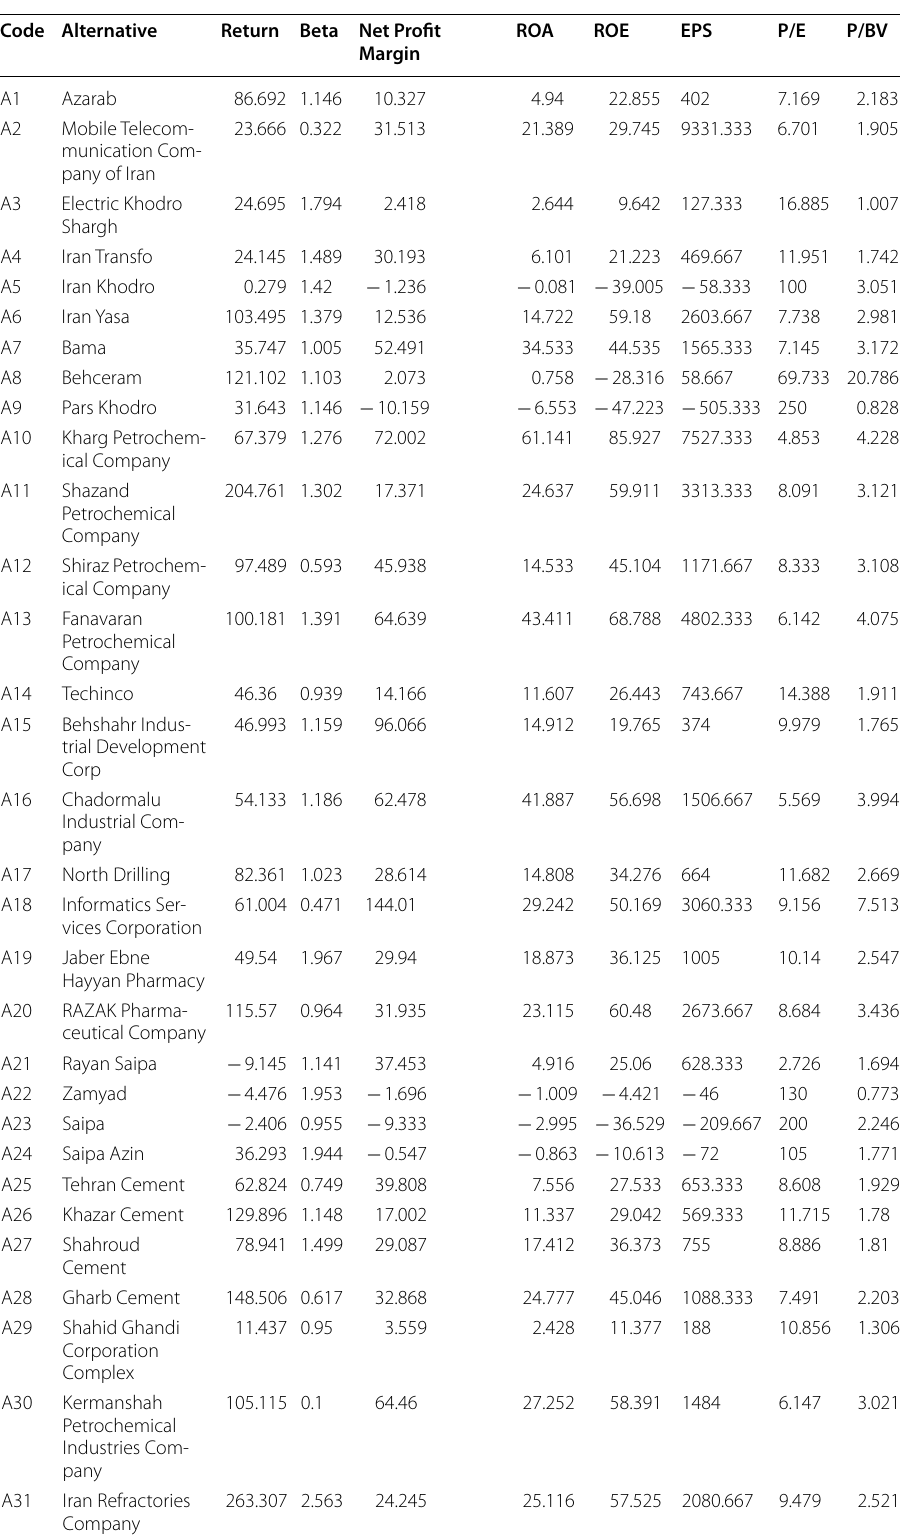
Table 3 Decision matrix Code